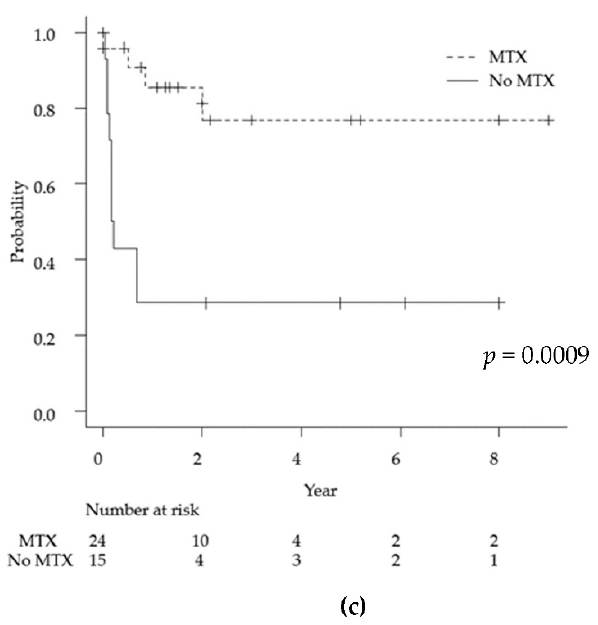
Figure 3. Kaplan-Meyer curves for overall survival for primary anaplastic large cell lymphoma of the central nervous system for each of the following factors: age ( a ), ALK positivity ( b ), and MTX treatment ( c ). ALK: anaplastic lymphoma kinase, MTX: methotrexate.